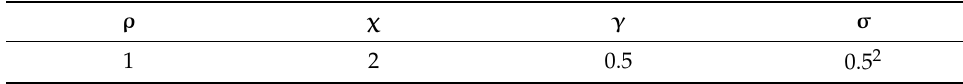
Table 3. Second Step Nelder–Mead Simplex algorithm options.